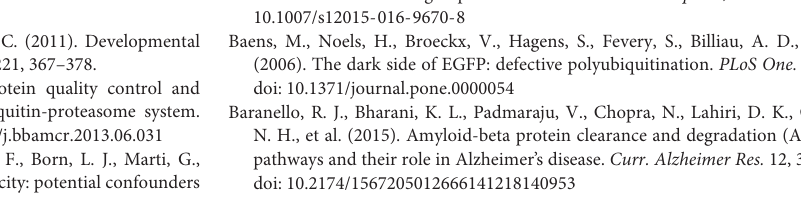
Supplementary Figure 4 | AHA labeling in yeast cells is non-toxic. (A) Growth assays on plates of yeast cells expressing ChAT and controls. Liquid cultures of yeast were spotting on selective inducing agar media and incubated at 30 ◦ C for 2–4 days before imaging. (B) Growth curves of (cid:49) pdr5 yeast cells expressing ChAT and controls grown in the presence or absence of 50 µ M L-azidohomoalanine (AHA). (C) Fluorescence microcopy of yeast expressing ChAT-YFP. Cells were imaged using a Leica TCS SP5 II confocal microscope at 63 × magnification. The scale bar represents 5 µ m. (D) Immunoblots of protein lysates of yeast cells expressing ChAT and controls grown in the presence of AHA probed with anti-ChAT or anti-histone H3 antibodies. Supplementary Figure 5 | AHA labeling induces a mild heat shock response in yeast. (A) Fluorescence microscopy of yeast cells expressing HSE-eGFP grown for 4 h in the presence or absence of AHA at 24 and 42 ◦ C and quantification ( B ; ∗ p ≤ 0.05, ∗∗ p ≤ 0.01; n = 5). (C) Anti-HSP immunoblots prepared with protein lysates from yeast cells grown in the presence or absence of AHA at 24 or 42 ◦ C and quantification (D) . Anti-histone H3 immunoblotting was completed as a loading